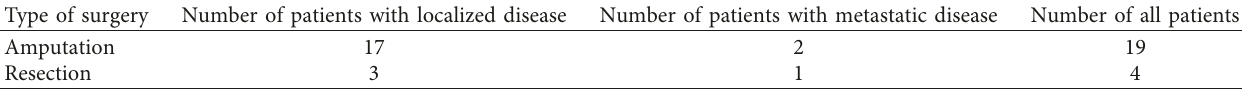
Table 3: Type of surgery.